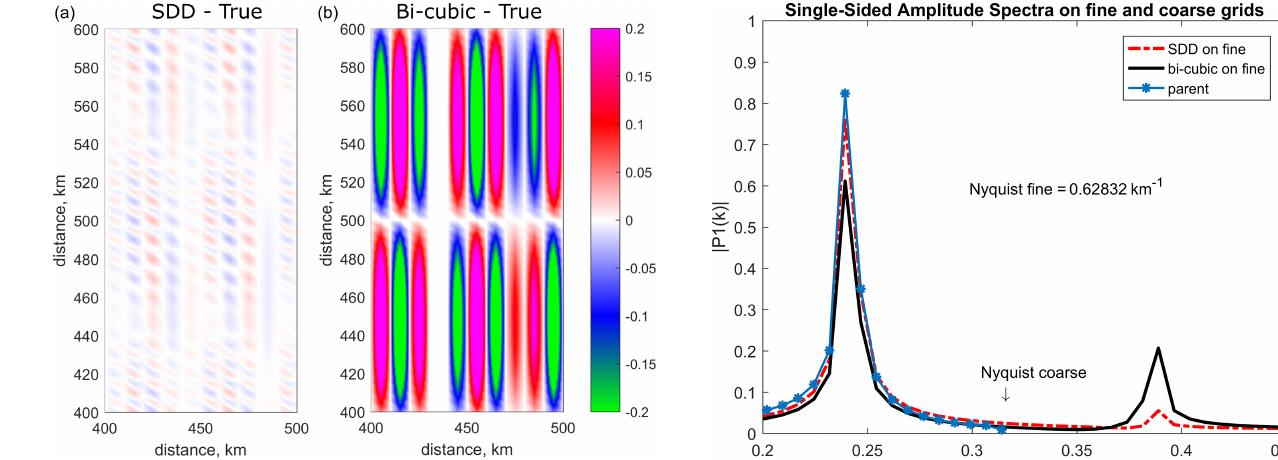
Figure 3. Comparison of skill between SDD and bi-cubic interpo- lation: (a) map of differences of parameter F values between SDD model and the true solution. (b) Map of differences of parameter F values between bi-cubic interpolation and the true solution. The colour bar limits are chosen to be between − 0 . 2 and 0 . 2 so the dif- ferences for SDD are visible; however, the maximum differences for the bi-cubic model are in fact between − 0 . 4 and 0 . 4.